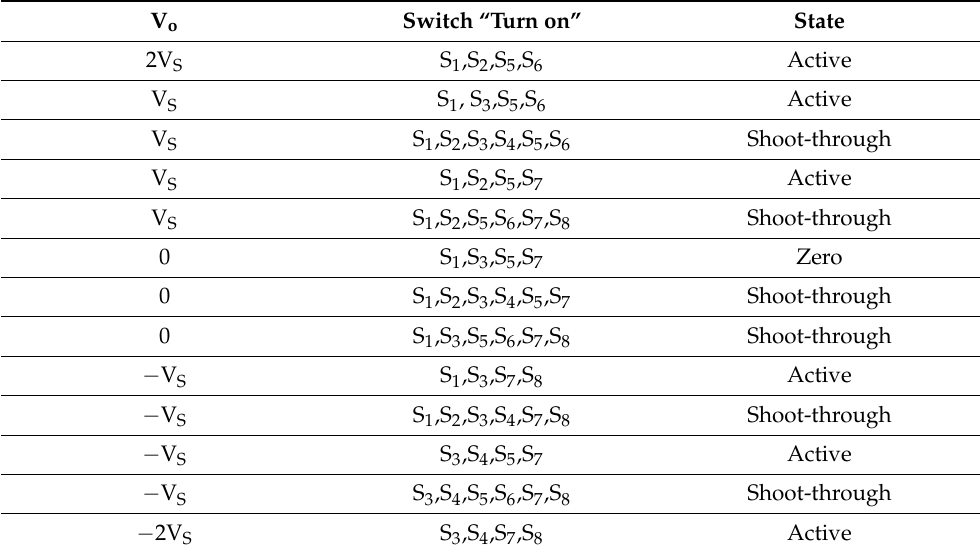
Table 8. Five-level qZMLI switching states.